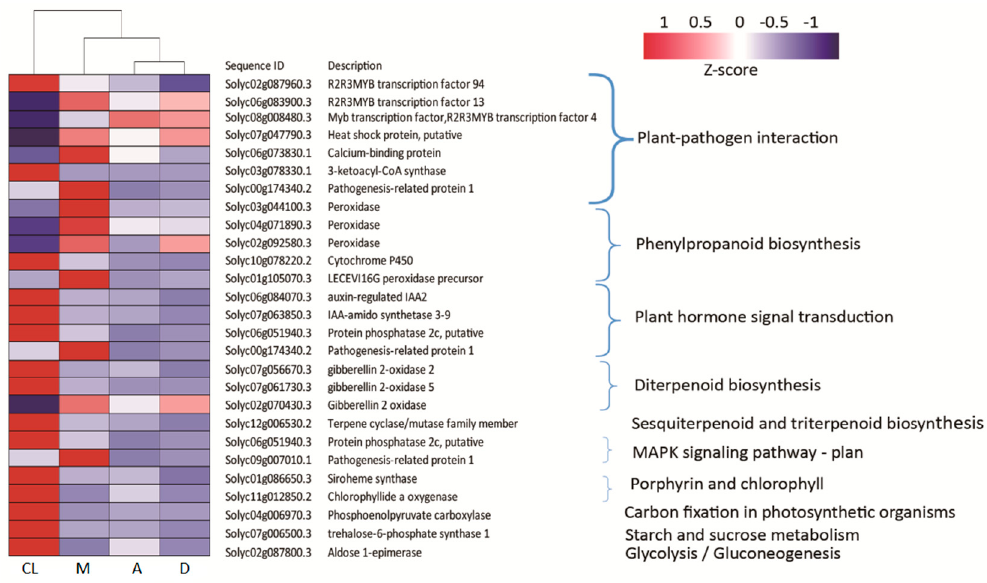
Figure 7. Heatmap of transcriptional levels for specific up- and down-regulated 27 DEGs enriched in DL compared with CL. In this heatmap, the columns represent tomato leaf samples treated with different light regimes, and the rows represent DEGS enriched in 10 KEGG pathways. Relative expression levels were normalized based on the Z-score and are shown as a color gradient from low (blue) to high (red).